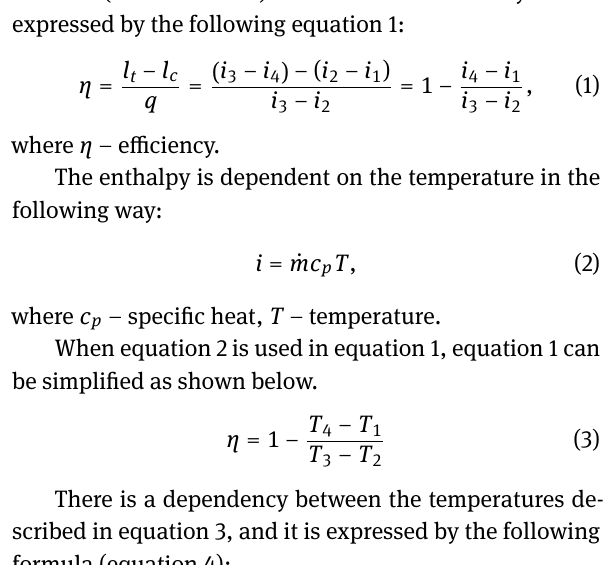
Figure 1: Brown coal consumption in Europe [6] What is more, gas microturbines could work not only as individual energy sources but also in cooperation with other commonly known systems such as hybrid systems with photovoltaic panels [7–11].